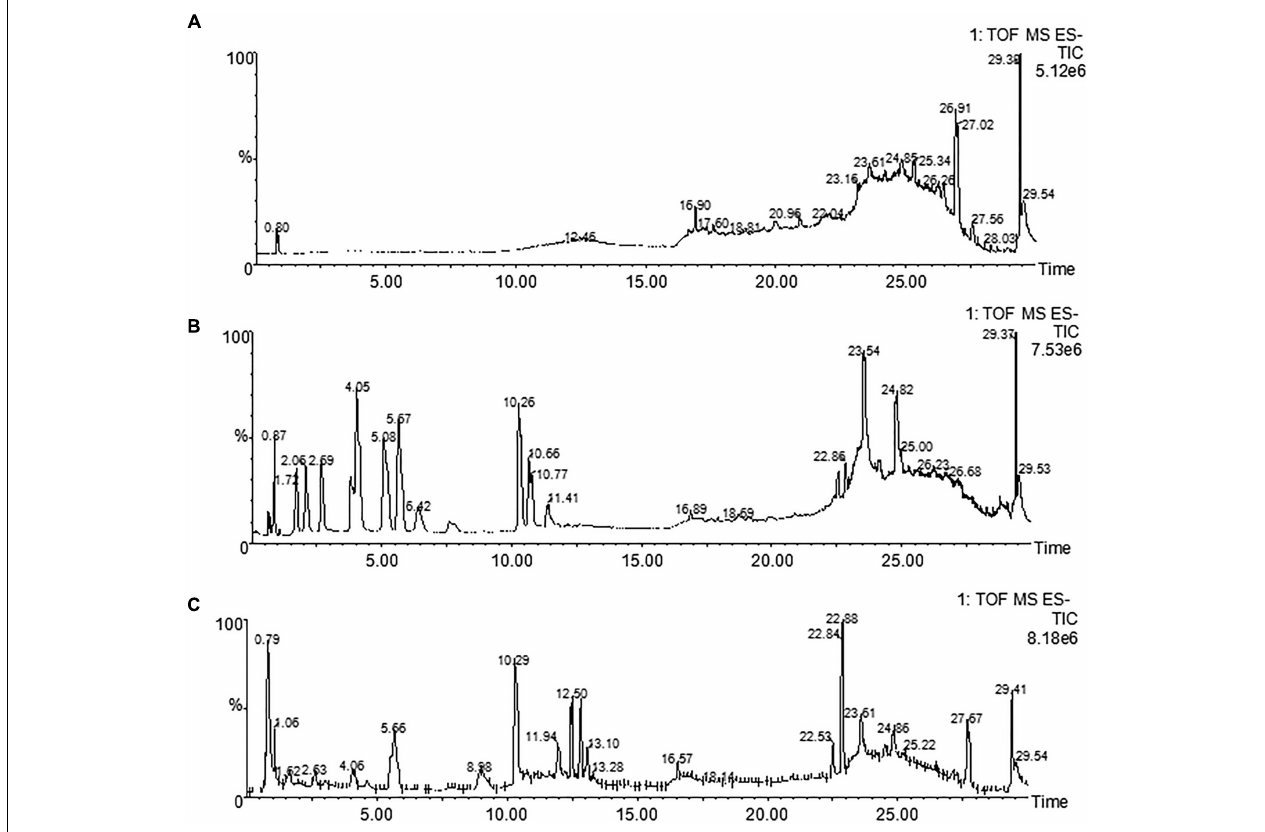
FIGURE 1 | UPLC-TOF-MS analysis of THSWD. Chromatographic fingerprints of control (A) , standard components (B) and THSWD (C) by UPLC-TOF-MS in negative ion